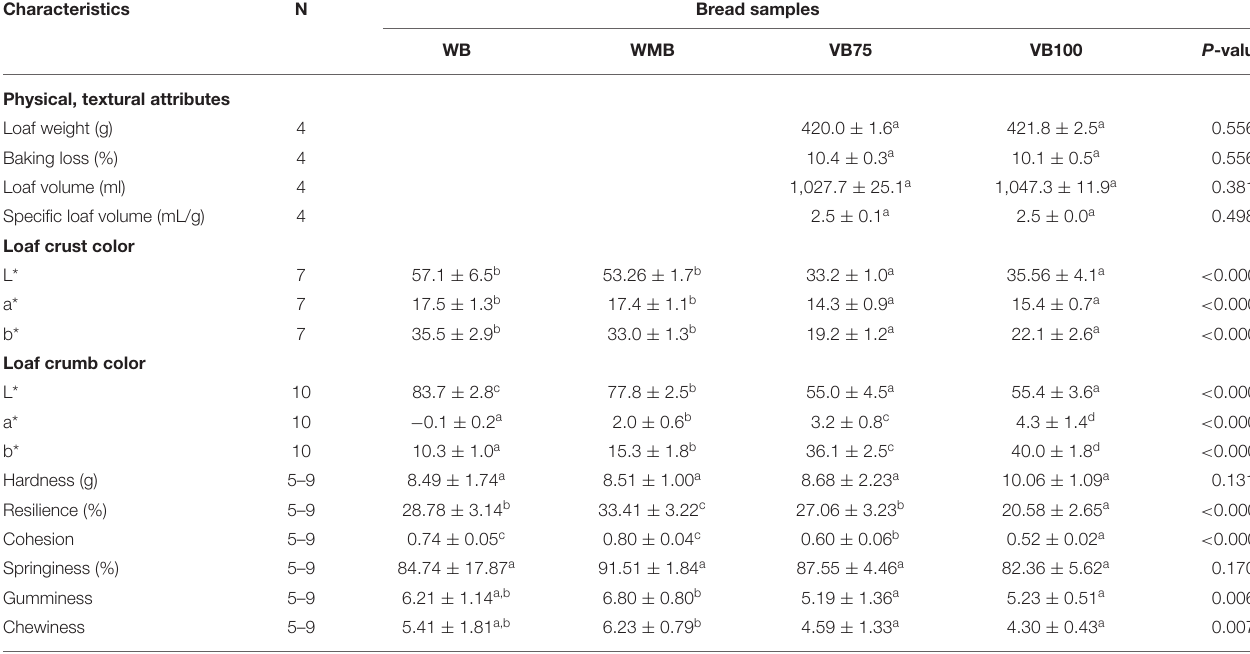
TABLE 3 | Physical and textural attributes of the four breads.